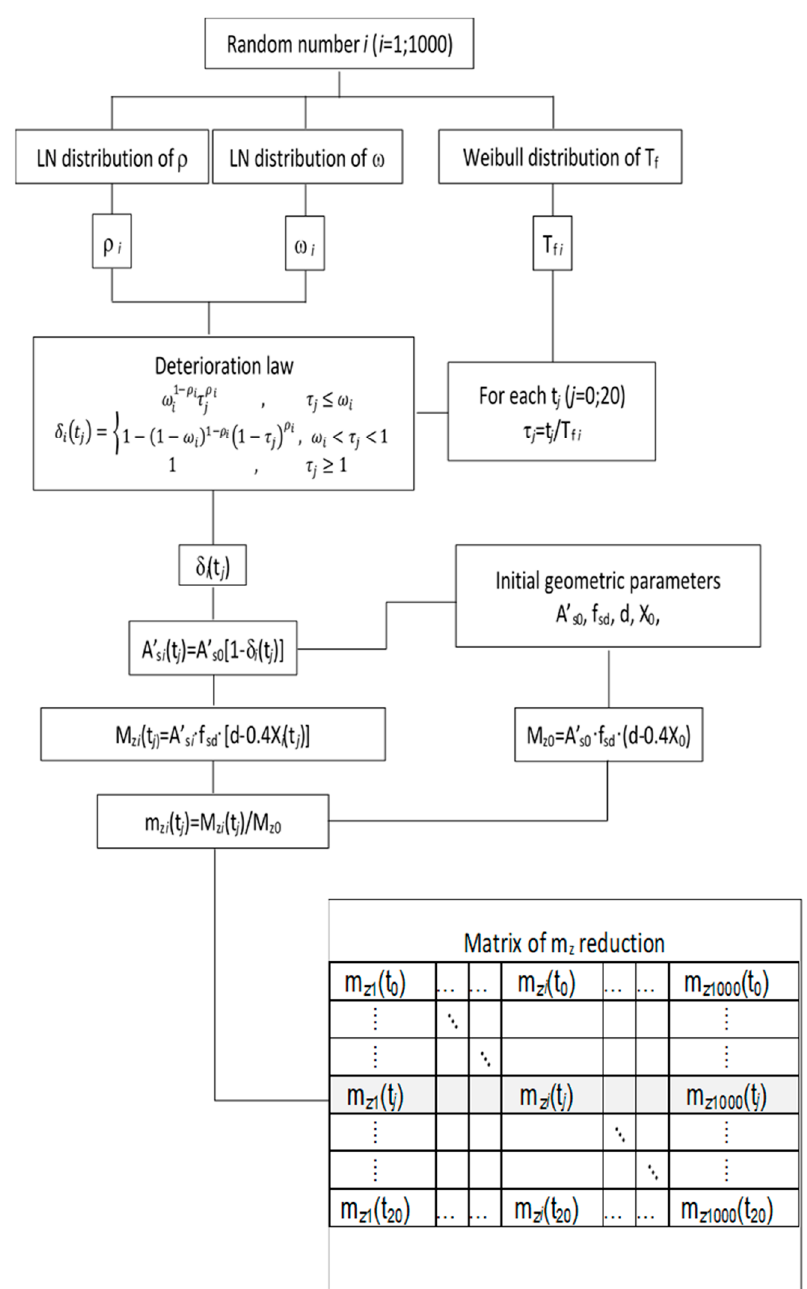
Figure 3. Procedure for probabilistic evaluation of the reduction in resistant action A ’ s (t) and the relative decrease in ultimate bending moment m z ( t ). This procedure is repeated 1000 times for 21 different instants of life between 0 and 100 years (with 5-years time step), thus producing 21,000 different samples of potential performance loss.